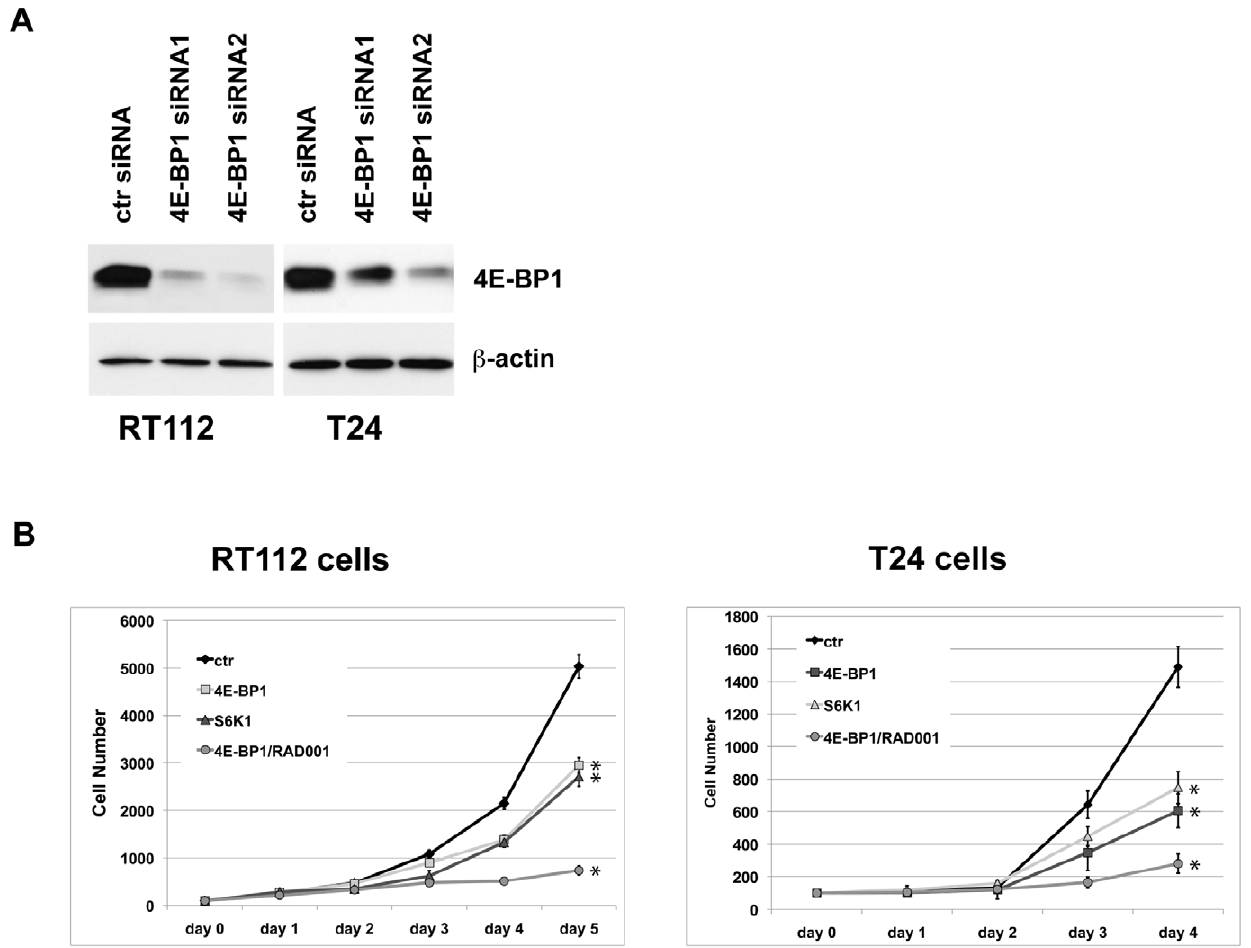
Figure 6. Combined activities of S6K1 and 4E-BP1 regulate cell growth. A: Two days after transfection with siRNAs against 4E-BP-1, protein expression in RT112 and T24 cells was detected in immunoblots. b -actin was used as a loading control. B: Growth of living cells, silenced for S6K1 or 4E-BP1 expression or cells silenced for 4E-BP1 expression and incubated with everolimus (RAD001) were monitored over time. Mean values 6 standard deviations are shown; statistical comparisons were performed using the student t-test (*: p , 0,05).